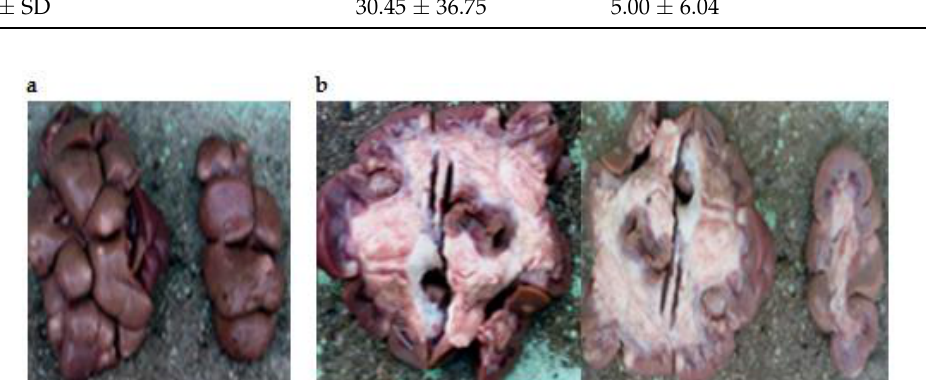
Figure 1. Focal non-purulent interstitial nephritis with whitish foci on the kidney surface ( a ) and on the cross section ( b ).